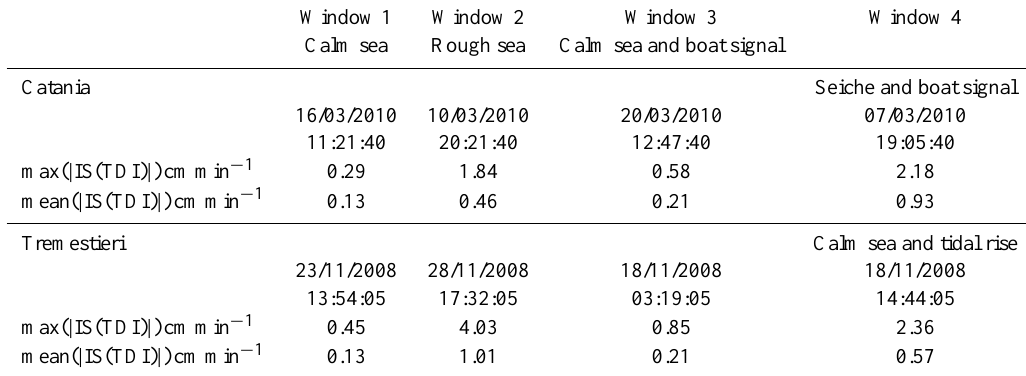
Table 2. Characteristic values of the maximum and the average of | IS | for the configuration C2 in the TDI of the four windows of the sea- level records where the synthetic tsunami signals have been added. The TDI corresponds to the first 30min of the window on the sea-level record on which the tsunami signal is superimposed and defines the interval where detection is valid. Date and initial time (hh:mm:ss) of the windows are